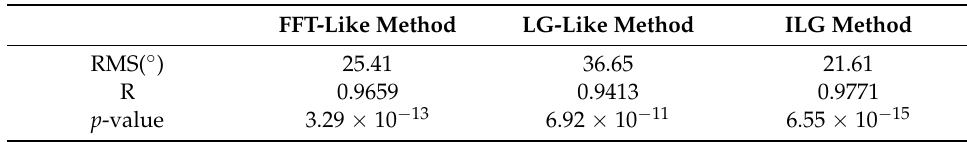
Table 2. The results of general statistics between wind directions obtained by different retrieval methods and CCMP data for 22 images.